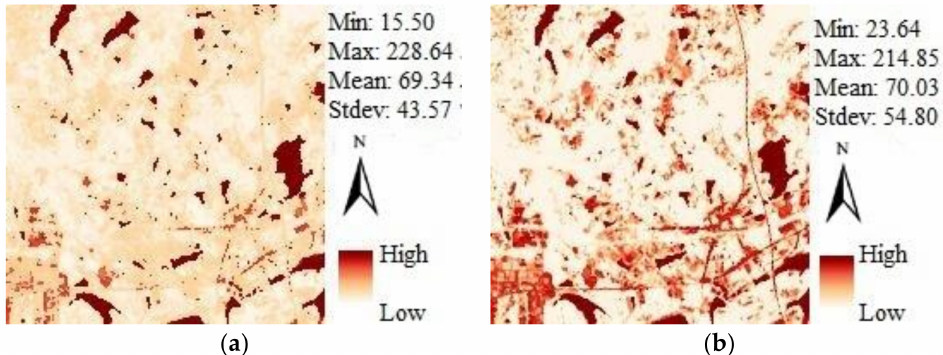
Figure 2. The distribution of soil heat flux ( a ) Surface Energy Balance Algorithm for Land (SEBAL), ( b ) Surface Energy Balance System (SEBS).